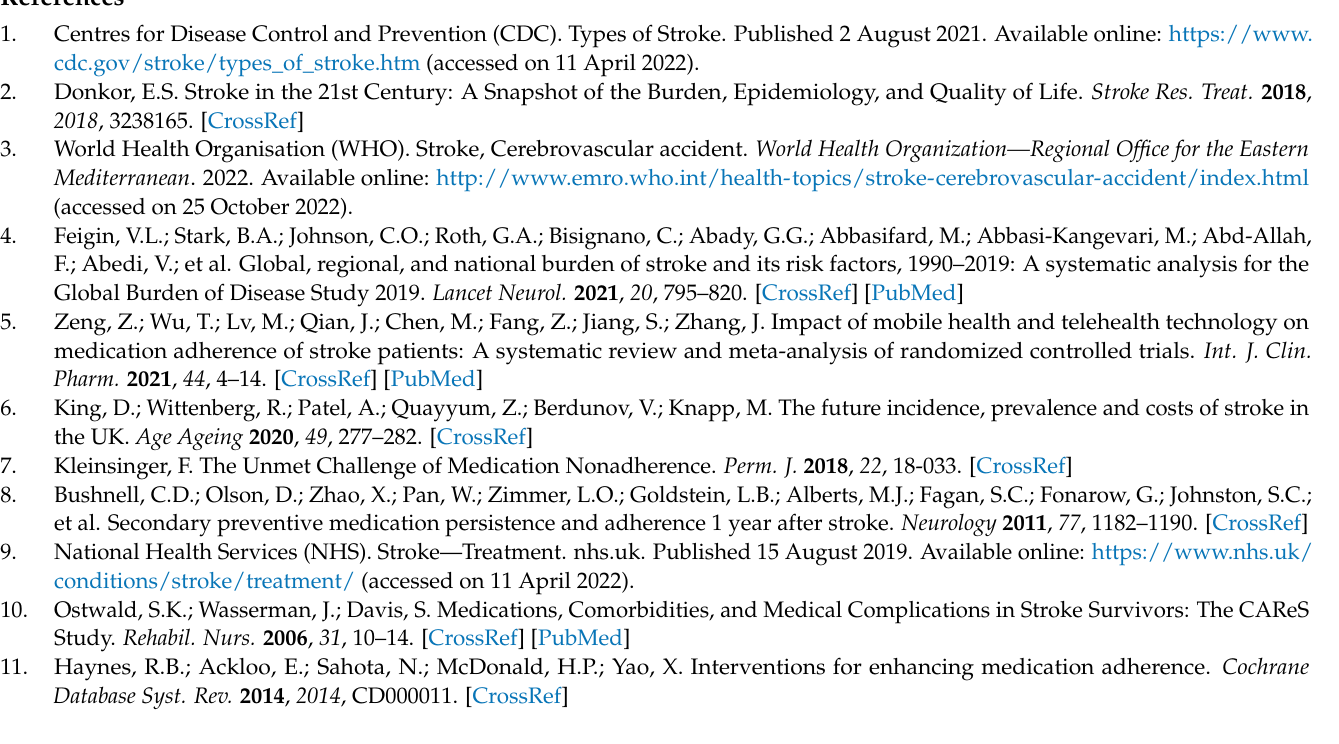
characteristics of included studies; Table S3: Behavioural analysis of the intervention components; Table S4: Included outcomes of eligible studies in the meta-analysis; Table S5: Coding of interven- tion acceptability; Figure S1: Subgroup analysis, intervention content, and continuous outcome; Figure S2: Subgroup analysis, intervention content, and dichotomous outcome; Figure S3: Subgroup analysis, outcome measurement, and continuous outcome; Figure S4: Subgroup analysis, outcome measurement, and dichotomous outcome; Figures S5–S12: Funnel plots for all